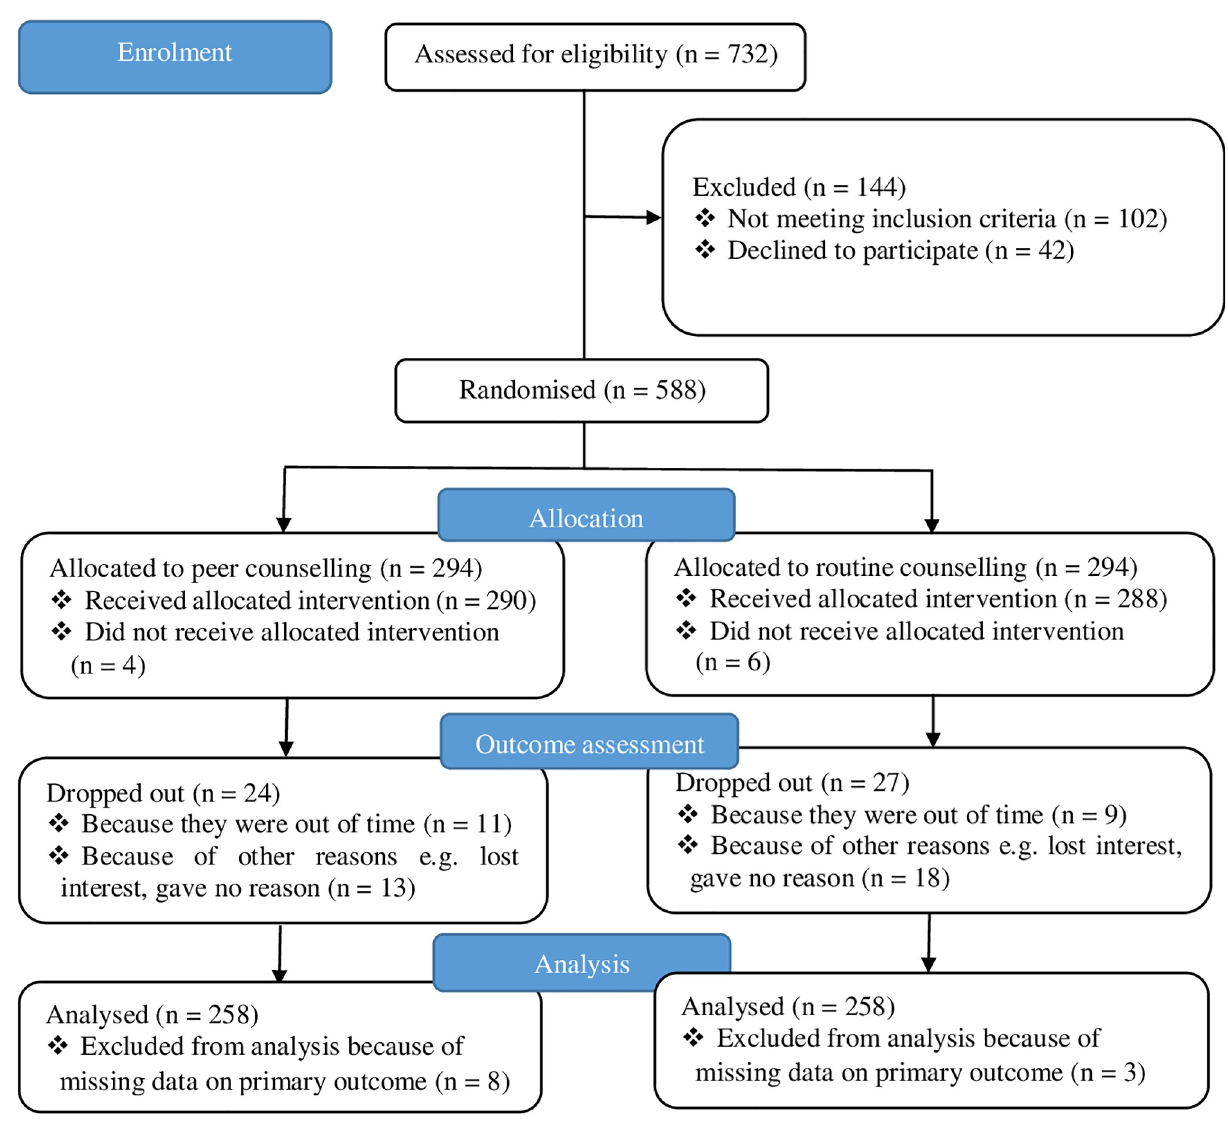
Fig 1. Trial profile showing enrolment and randomisation of study